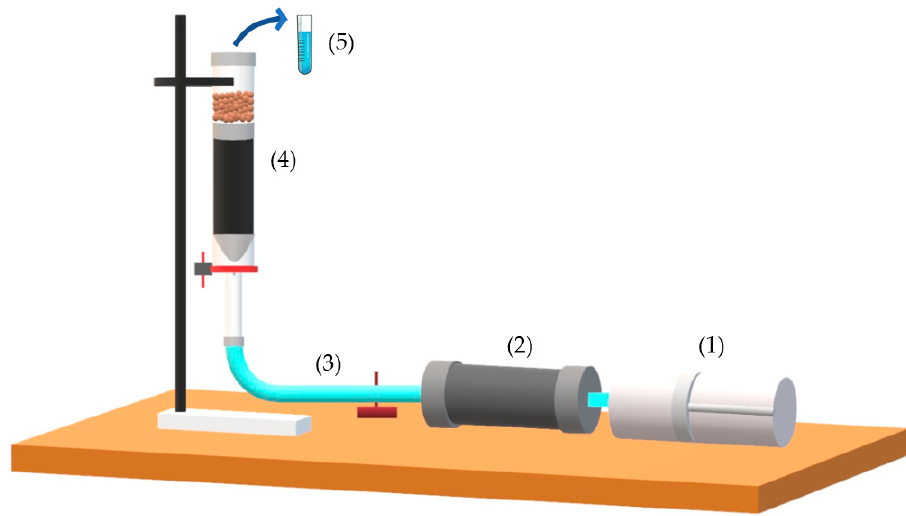
Figure 2. Experimental setup for dynamic adsorption tests consisting of (1) positive displacement pump, (2) cylinder, (3) regulating valves, (4) open packed-bed system and (5) effluent collection.